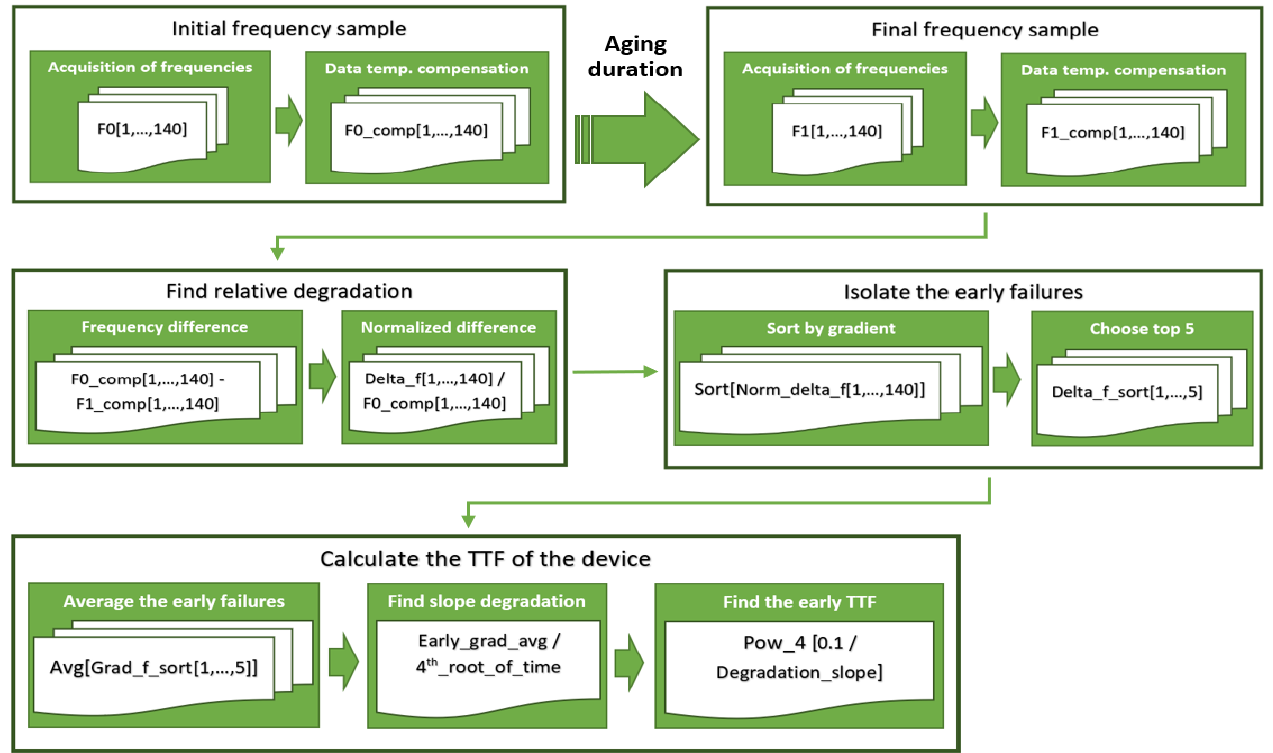
Figure 8. A diagram of the flow for implementing temperature compensation and early failure filtering into a MHM system. The techniques are performed on 140 three-stage ring oscillators.